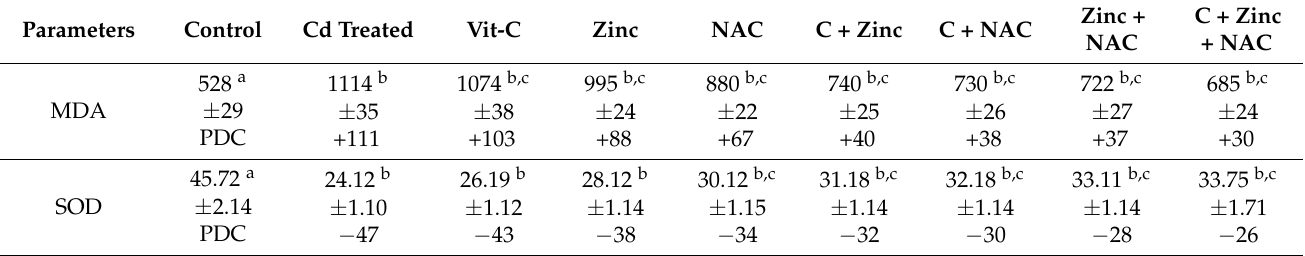
Table 5. Levels of Antioxidant Enzymes and Products in Kidney tissue of Control and Experimental